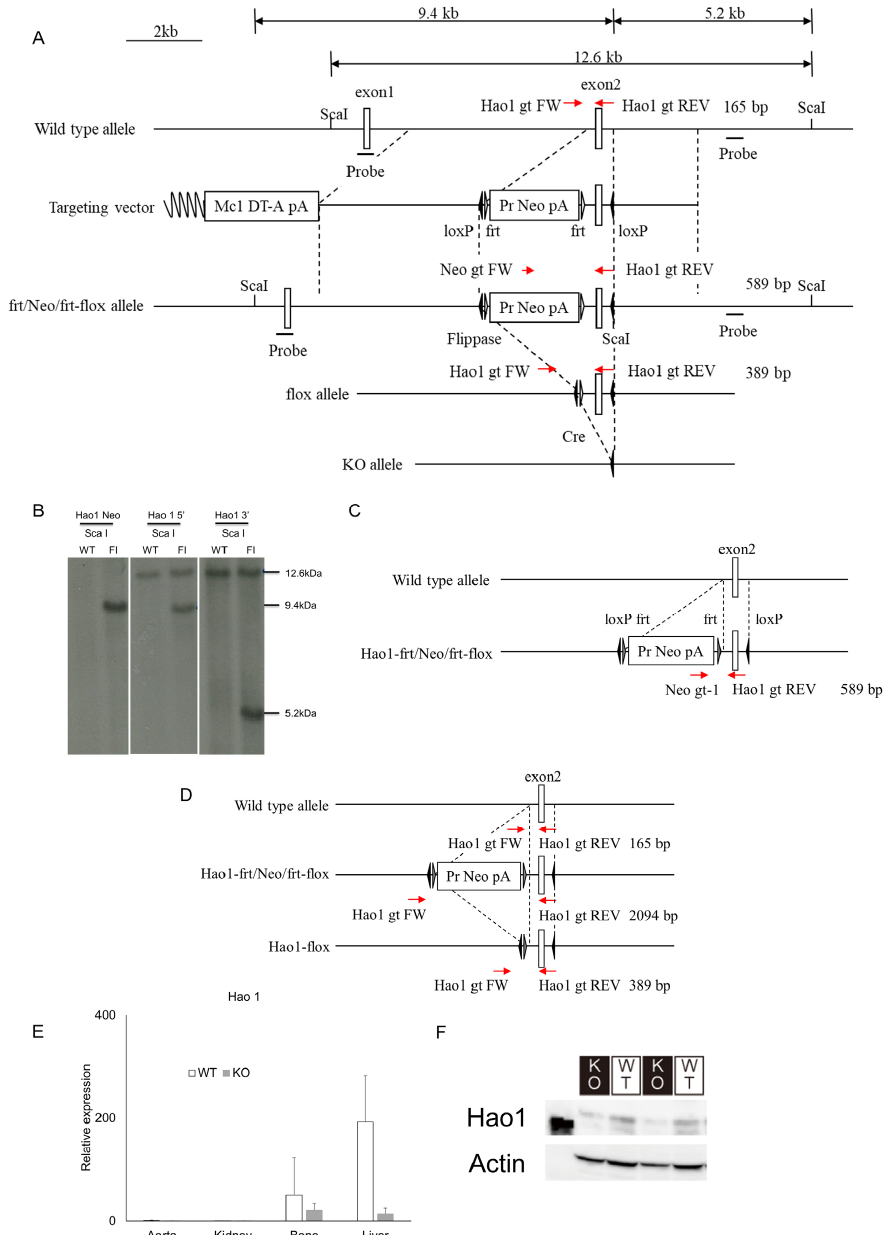
Figure 2 Figure 2. Establishment and characterization of Hao1 conditional knockout models. ( A – D ) We generated a targeting vector in which Hao1 exon 2 was flanked by loxP sequences and used it to transduce ES cells by homologous recombination ( A ). Neomycin-resistant colonies were picked and homologous recombination at the target site confirmed by Southern blot analysis of Sca1-digested genomic DNA. Blots were hybridized to either a 5 (cid:48) or 3 (cid:48) probe, identifying respective 9.4 kb or 5.2 kb fragments ( B ). The neomycin-resistant cassette flanked by frt sequences was deleted using flippase enzyme ( C , D ), and resultant ES cells were implanted into surrogate mothers. Hao1-flox F1 chimeric mice were obtained and bred to generate homozygous Hao1-flox mice. ( E ) Aorta, kidney, bone and liver were collected from ten-week-old WT and Hao1-deleted CAG-Cre/Hao1 flox/flox (KO) mice, and Hao1 mRNA expression was analyzed by real-time PCR. Shown is relative Hao1 expression in indicated tissues compared with that in wild-type aorta ± S.D. ( F ) Liver was collected from ten-week- old WT and Hao1-deleted CAG-Cre/Hao1flox/flox mice and Hao1 protein expression was analyzed by Western blotting. Red arrow symbols means the direction of each